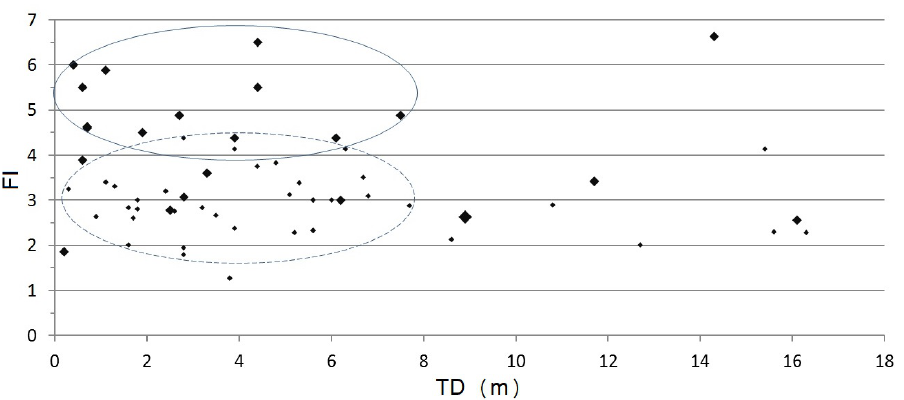
Figure 10. Flatness Index (FI) vs. Transport Distance (TD) diagram. Symbol size is related to the clast size (small = coarse boulder, medium = very coarse boulder, large = fine block). The solid blue line and the dashed blue line encloses the areas of highest incidence for very coarse and coarse boulders,